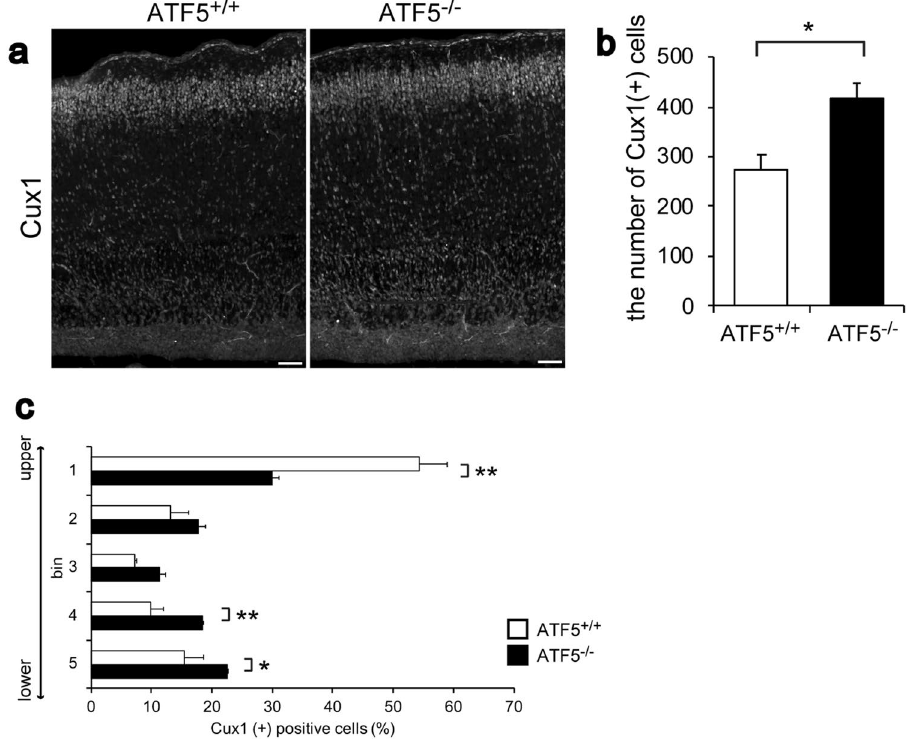
Figure 5. Abnormal number and distribution of upper cortical layer-specific neurons in the ATF5 −/− cortex on postnatal day 0 (P0). ( a , b ) Immunostaining for Cux1, an upper cortical neuron marker (layers II–VI), in cortical sections on P0. ( b ) Quantification of the number of Cux1-positive cells in the cortex. ( c ) Quantification of the percentage of Cux1-positive cells divided equally into five bins of the cortex. Data are presented as mean ± S.E.M. ( n = 3 mice per group, * p < 0.05, ** p < 0.01; Student’s t-test ( b ), two-way ANOVA followed by Tukey HSD test ( c )). Scale bars represent 50 µm.